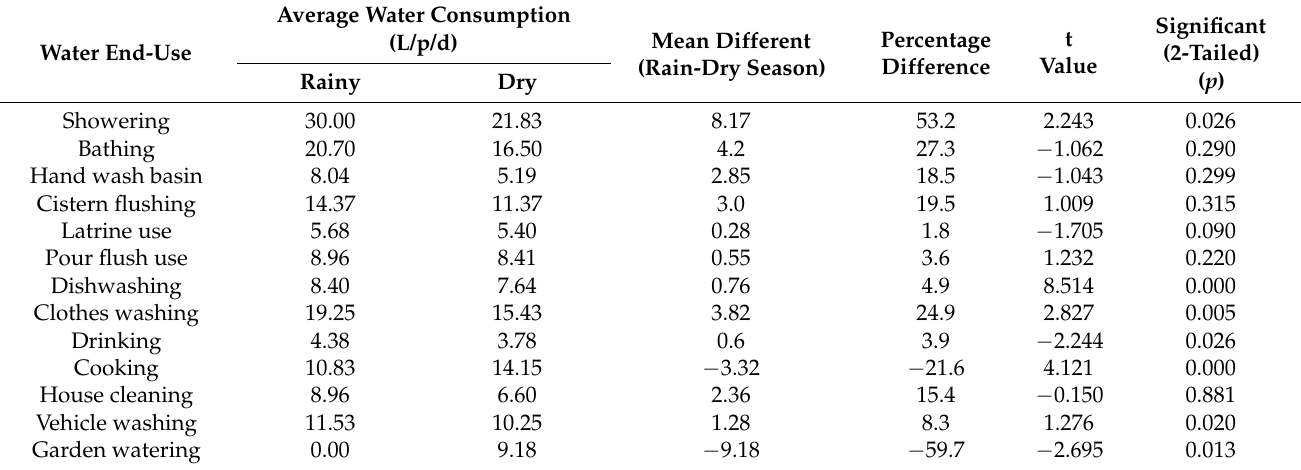
Table 6. Statistical comparison of water end-uses between rainy and dry